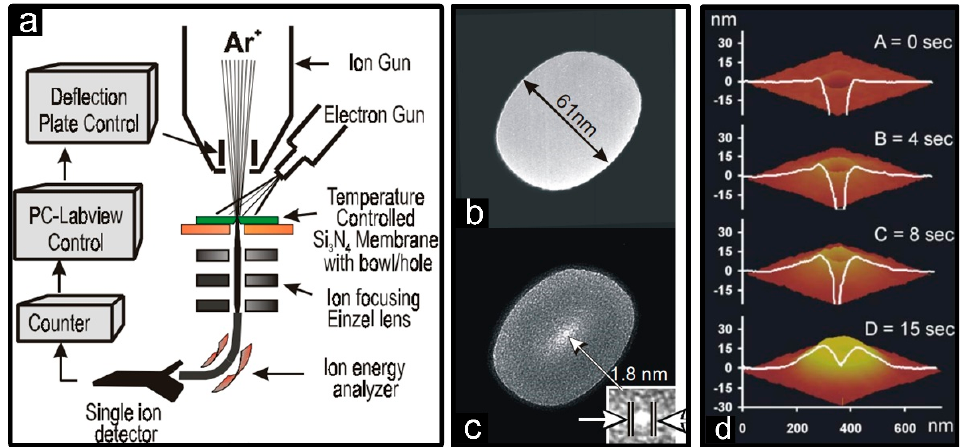
Figure 4. FIB-induced material migration. ( a ) Ion-beam sculpting system. ( b , c ) Argon ion beams sculpted Si 3 N 4 nanopores from 61 nm to 1.8 nm [23] . ( d ) AFM surface scans after 0, 4, 8, and 15 s beam exposures [74] .